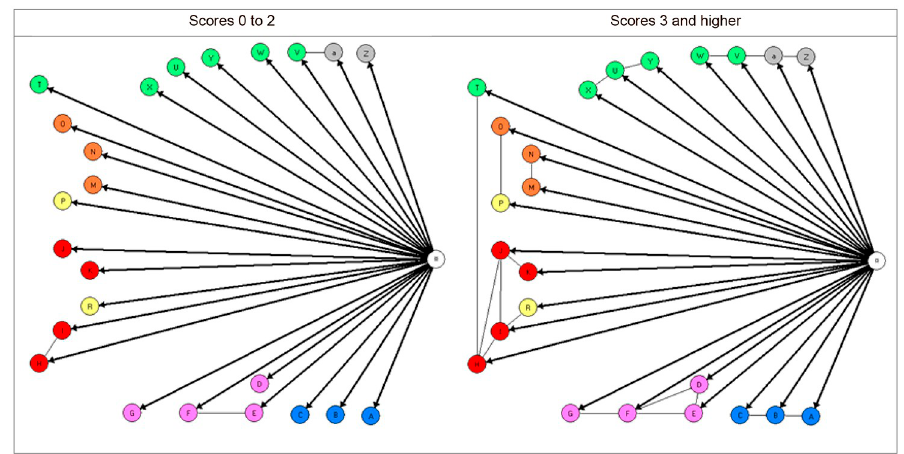
Fig 2. The graphical loglinear Rasch models for the two latent classes of infants scoring 0 to2 and 3 or higher, respectively, on the 24-item CIMHQ. Note: The color code signifies items from the seven different domains in CIMHQ: Blue: Sleep regulation (items A, B, C). Purple: Eating (items D, E, F, G). Red: Expression of emotions (items H,I, J, K). Orange: Concentration, attention and distractibility (items M, N, O). Yellow: Motor activity (items P, R). Green: Communication and interaction (items T, U, V, W, X, Y). Gray: Language (items Z, a). Connections between items signify that these items are locally dependent.